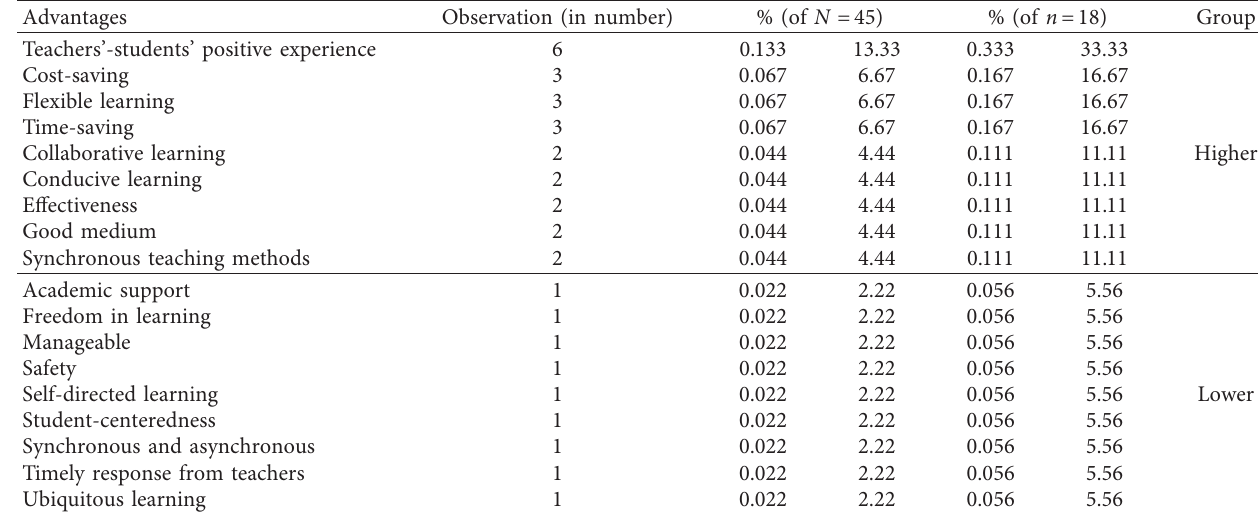
Table 4: Percentage of each advantage of online learning and their groups based on 50th quartile.